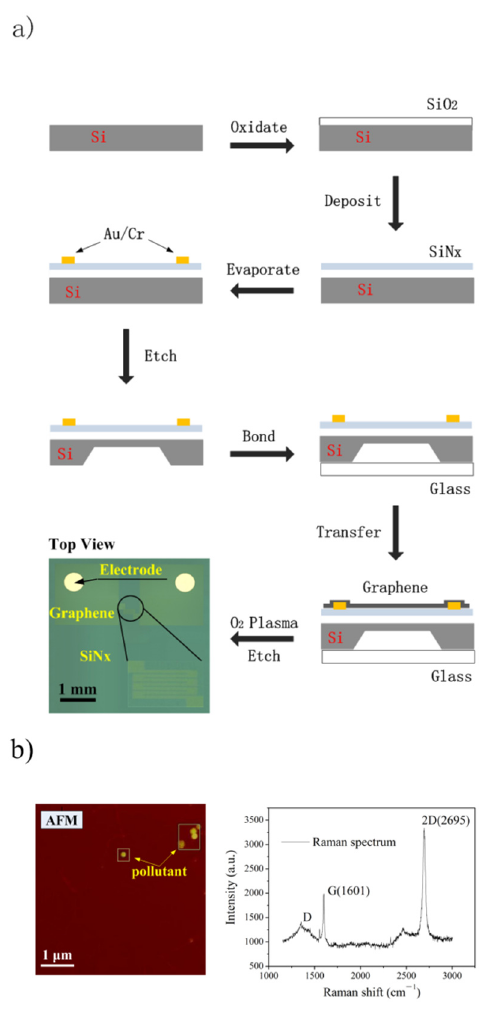
Figure 2. Preparation and characterization of the device: ( a ) technological process for fabricating devices; ( b ) atomic force micrograph and Raman spectrum of graphene.